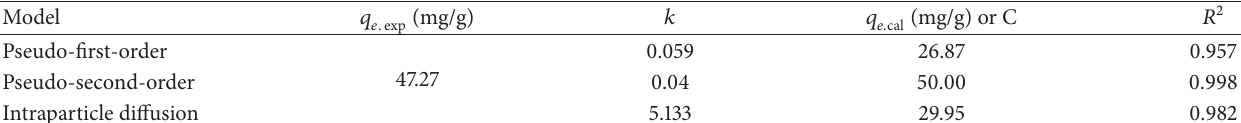
Table 2: Kinetic model parameters for Cr(VI).